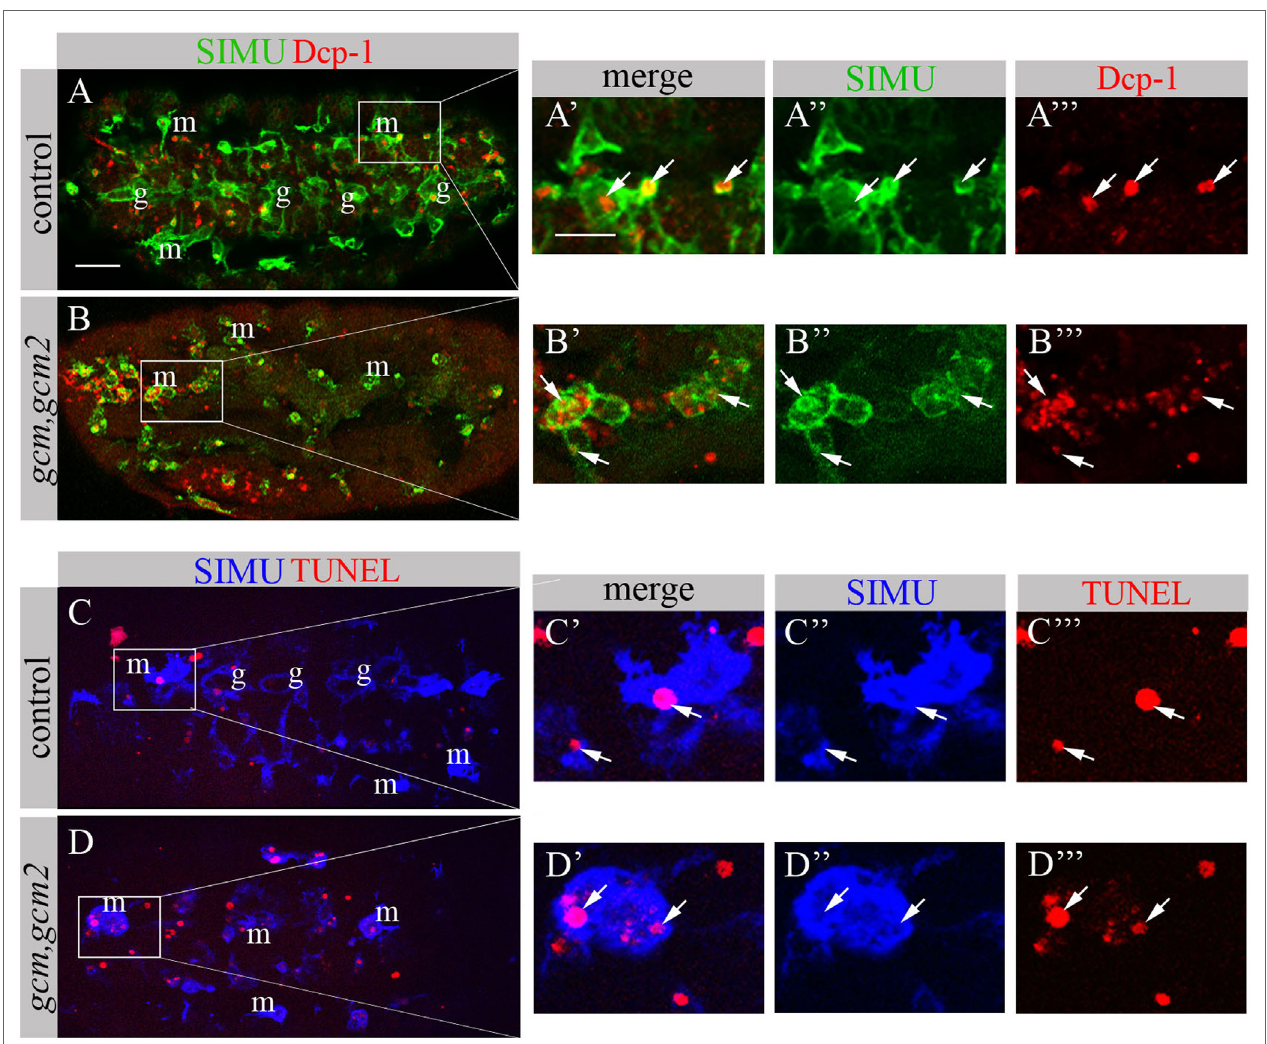
FigUre 8 | gcm,gcm2 mutant macrophages phagocytose apoptotic cells. (a–D’’’) Projections from confocal stacks of the stage 16 embryo; (a–B’’’) apoptotic cells are in red (Dcp-1), SIMU protein with anti-SIMU in green. (c–D’’’) TUNEL in red, SIMU protein with anti-SIMU in blue. (a–a’’’, c–c’’’) Ventral view of control embryos displays SIMU expression in glia (g) and macrophages (m). Dcp-1 and TUNEL staining are found inside SIMU-labeled cells [ (a-a’’’, c–c’’’) arrows]. (B–B’’’, D–D’’’) gcm,gcm2 deficient embryos; no glia are labeled with SIMU but macrophages are (m). Dcp-1 and TUNEL staining are found inside SIMU-positive macrophages (arrows). Bar, 20